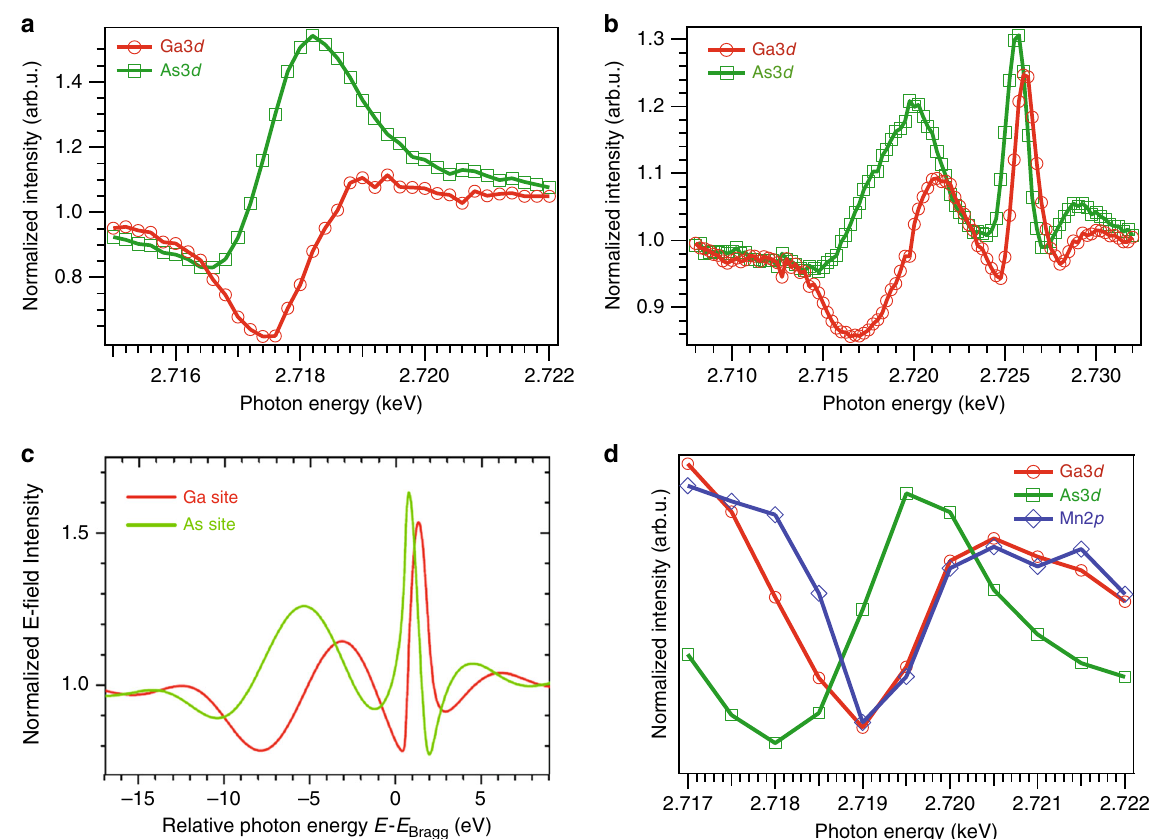
Fig. 3 Energy-scan standing-wave core-level intensities. The photon energy was scanned over the (-1-1-1) Bragg condition, centered at about 2718 eV. a The variation of As 3 d and Ga 3 d intensities from undoped GaAs through such an energy scan, with obvious strong differences in behavior. b A similar energy scan for a sample with 100 nm of Ga 0.95 Mn 0.05 As grown on GaAs(001). Two Bragg peaks are observed, due to the slight difference in the lattice constant of the doped sample, with similar differences in phase between As 3 d and Ga 3 d in going over both of the peaks. c Dynamical diffraction simulations of the photoelectron intensity from different sites as a function of photon energy, which show very good agreement with experiment in b . d An energy scan of Ga 3 d , As 3 d and Mn 2 p over narrower range for the doped sample. The near identity of the curves for Ga and Mn indicates a high degree of substitutional sites for Mn, and was con fi rmed with similar data for a (311) re fl ection (not